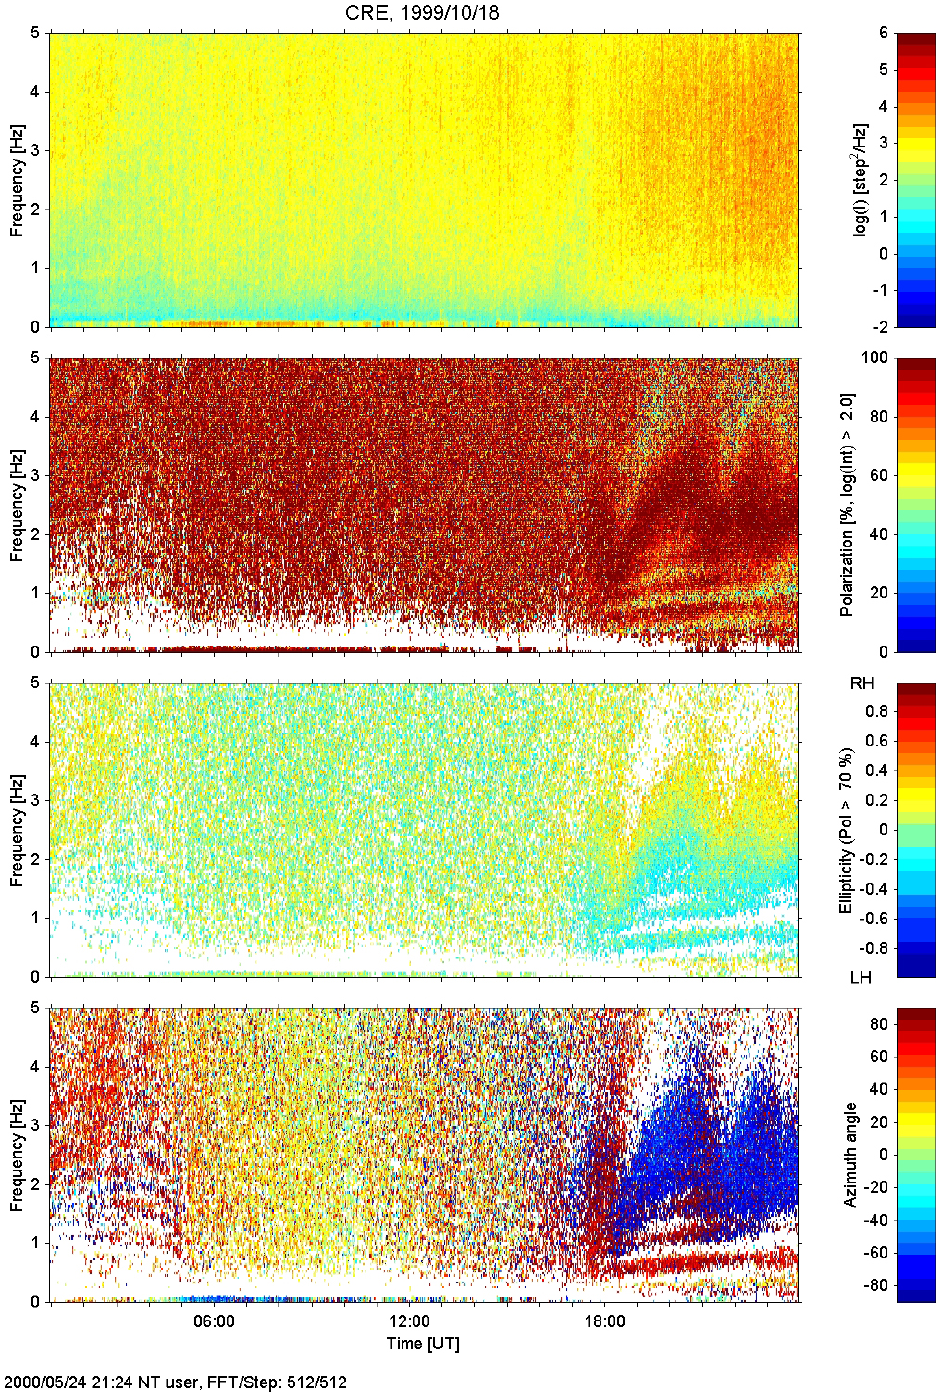
Fig. 3. Upper panel: the power spectral density (PSD) of the magnitude of the horizontal magnetic disturbance (noise) vector in a color- coded form, of arbitrary scale (step or byte to the power of two per Hz). Second panel from above: the degree of polarization in % for all PSD levels above 10 2 in the upper panel. Second panel from below: the ellipticity (cid:15) = (L − R)/(L + R) , where R and L represent the right- and left-hand circularly polarized components, in color-coded form with “red” for right-hand ( (cid:15) =+ 1) and “blue” for left-hand ( (cid:15) =− 1) circular polarization for all PSD levels with a degree of polarization greater than 70% (see adjacent upper panel). Bottom panel: the angle of the major axis of the horizontal polarization ellipse with the direction of magnetic east in degrees; the angle is counted positively in the counterclockwise direction. for three selected UT sectors (LT=UT + 1.5h). Copyright by